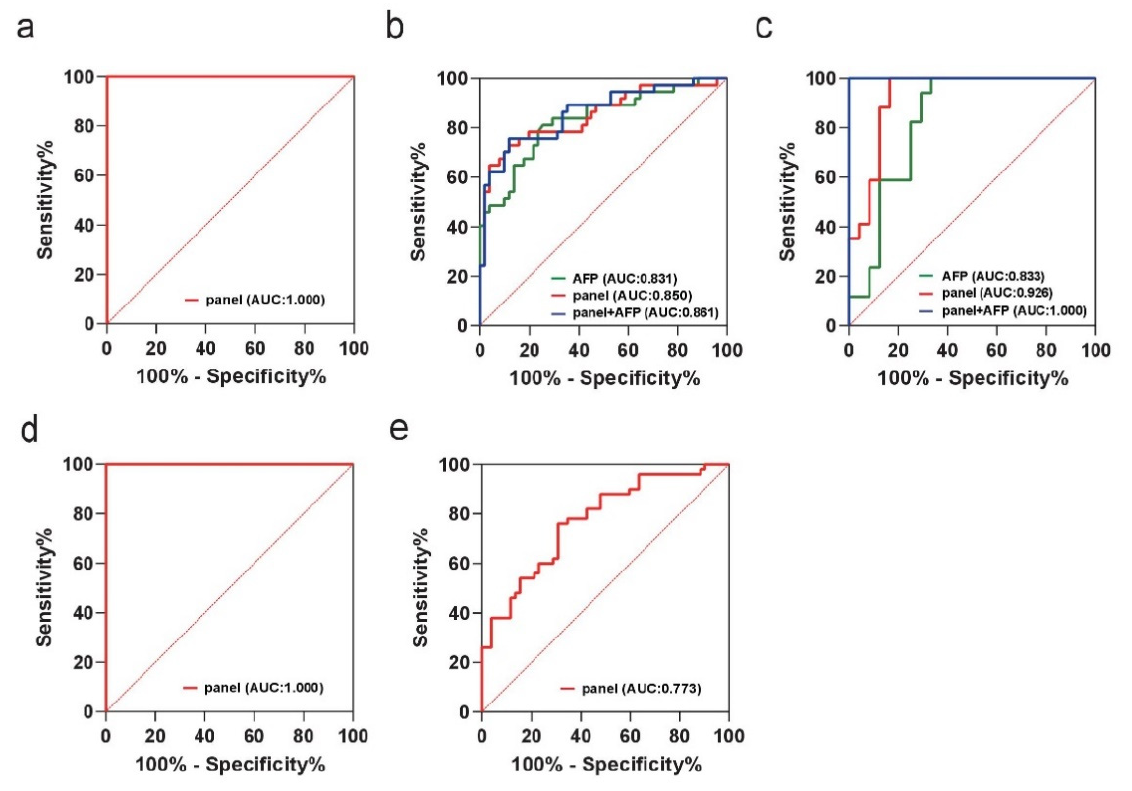
Figure 6. ROC curve analysis following binary logistic regression. The diagnostic performance of the lipidomic biomarker panel in discriminating HCC from ( a ) normal controls (NCs) in the training set. Comparison of the diagnostic performance of the lipidomic biomarker panel with that of serum alpha-fetoprotein (AFP) and their combination in discriminating HCC from liver disease (LD) in the ( b ) training set and ( c ) validation set. The ROC curve of the lipidomic biomarker panel also showed excellent discriminability in discriminating AFP-negative HCC patients from ( d ) NCs and ( e ) AFP-negative LD patients. The red-, green-, and blue-colored lines indicate lipid biomarkers, AFP, and lipid biomarkers with AFP, respectively.